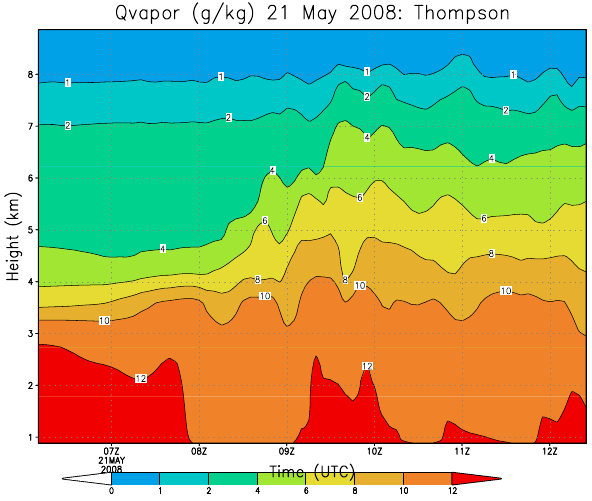
Fig. 10. Temporal evolution of atmospheric water vapour (gKg − 1 ) over Gadanki associated with the thunderstorm on 21 May. The simulations are with the Thompson microphysical